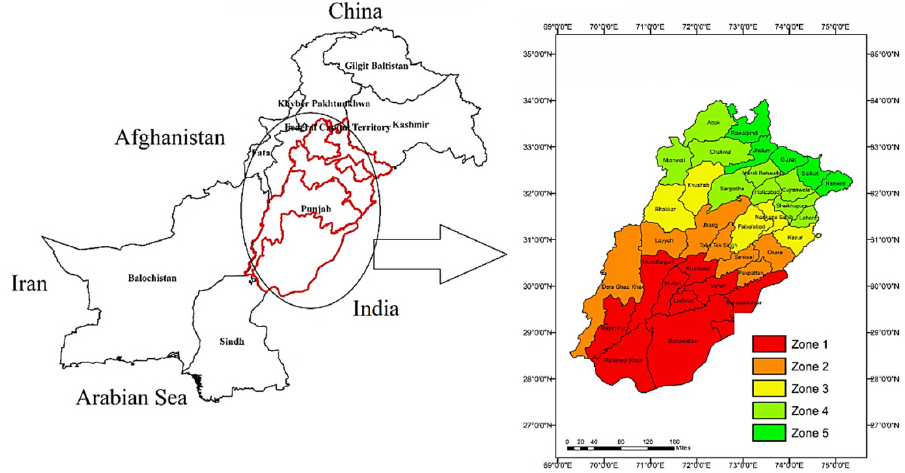
Figure 1. Study area map of Punjab, Pakistan, where different colors represent the selected zones.